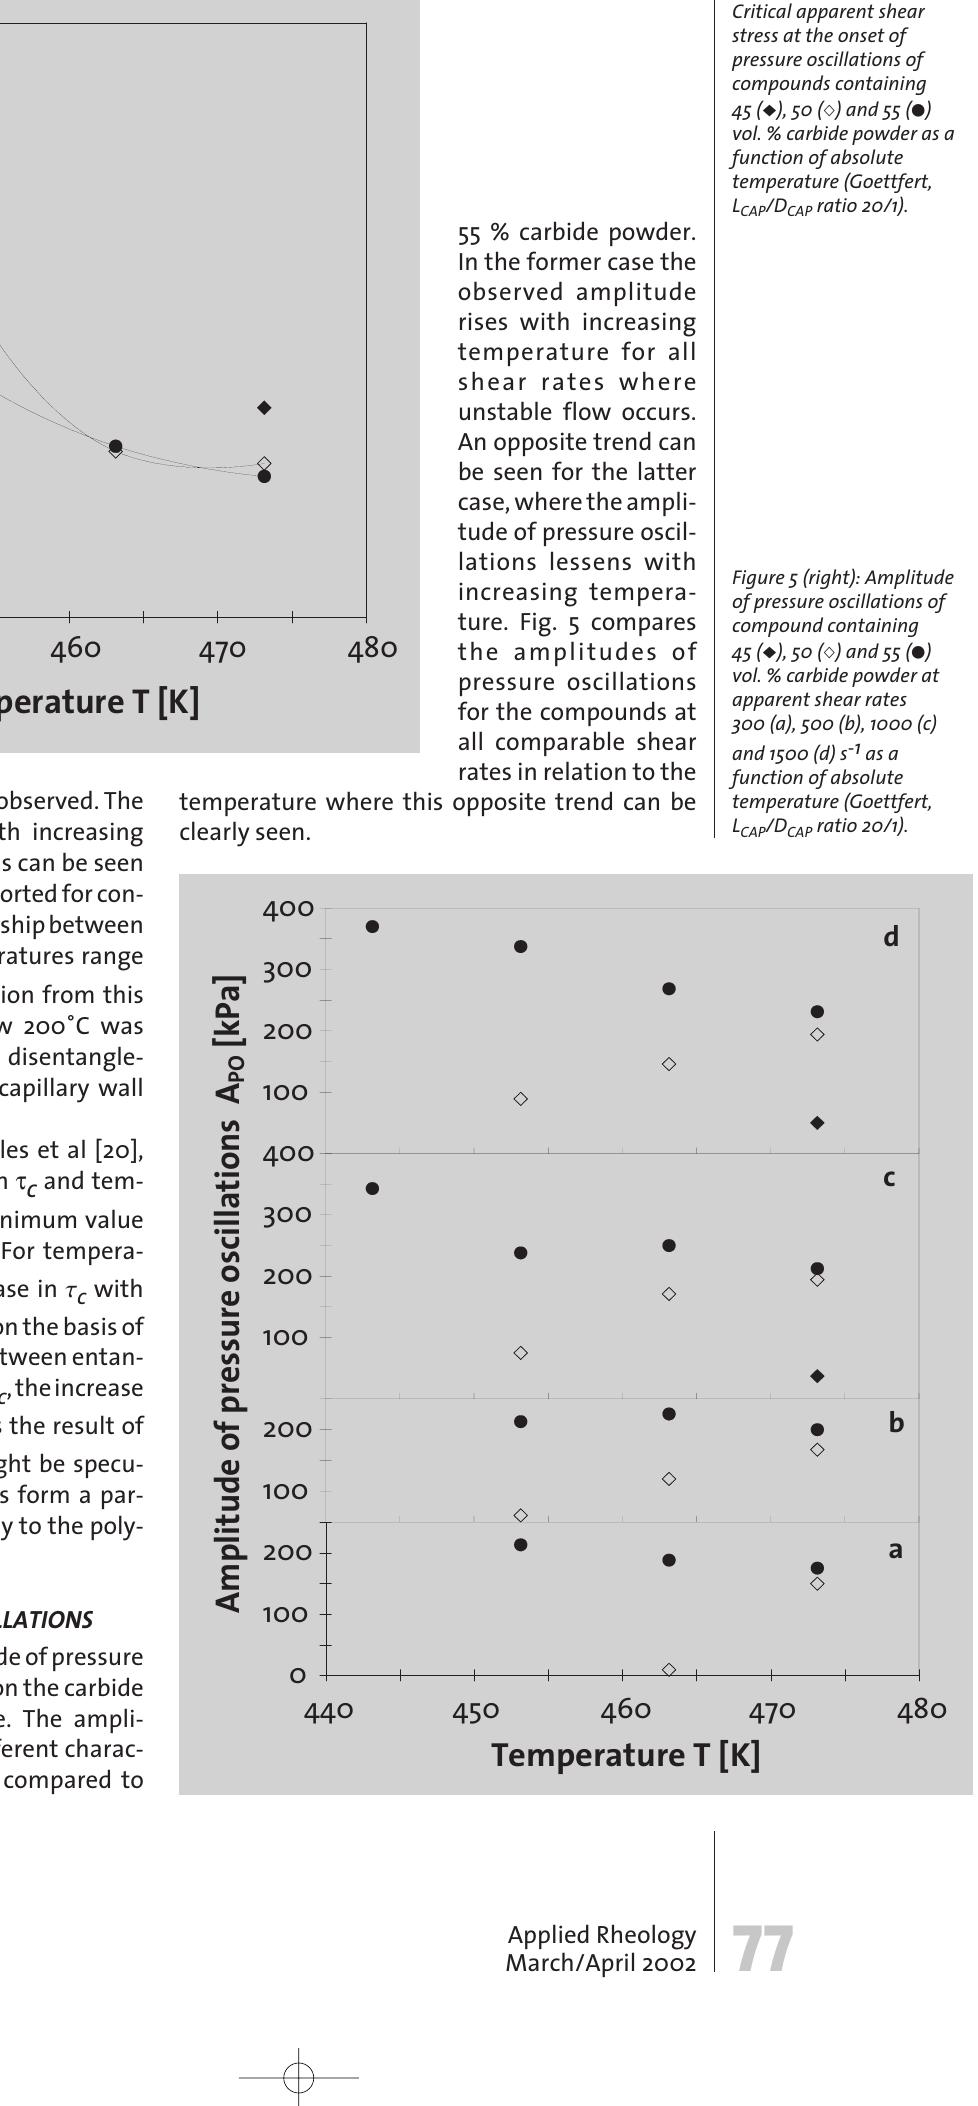
Figure 4 (left): Critical apparent shear stress at the onset of pressure oscillations of compounds containing 45 ( Ï ), 50 ( Ì ) and 55 ( Ê ) vol. % carbide powder as a function of absolute temperature (Goettfert, L CAP /D CAP ratio 20/1).